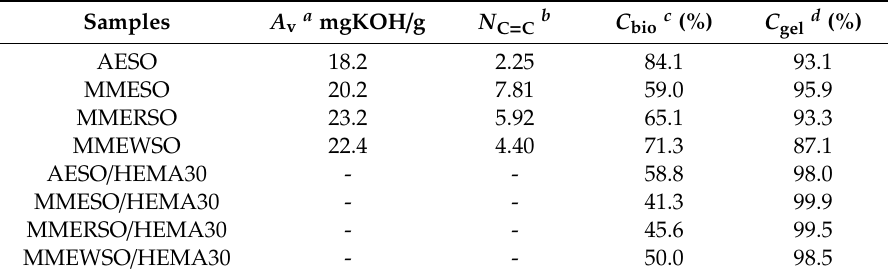
Table 2. Properties of UV-cured EA-like samples. AESO: acrylated